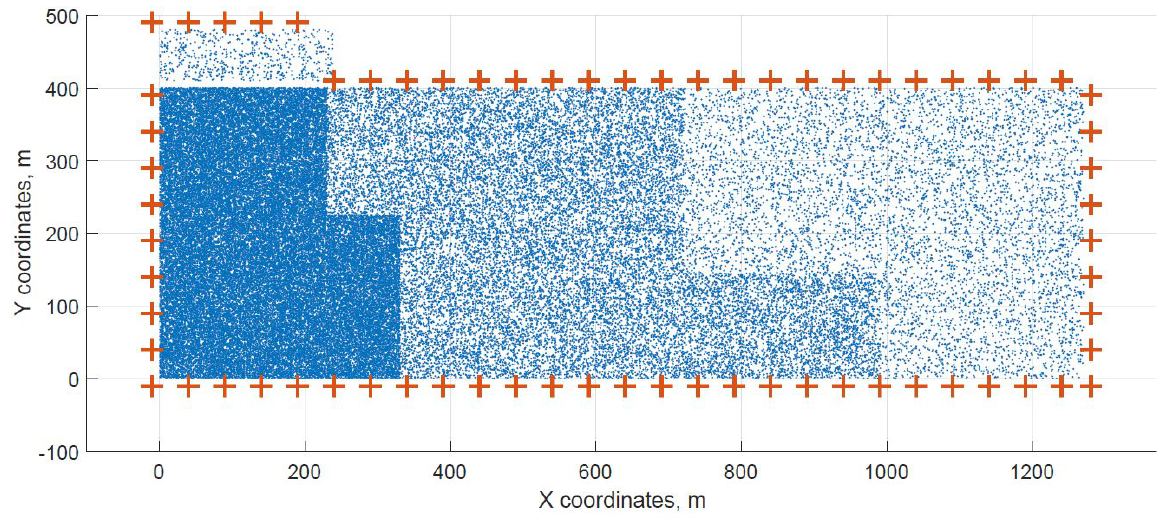
Figure 6. Original distribution with users outside of the area for dataset G. Table 7. Calculation results for CUCKS and DE algorithms using 10,000 iterations. Theor. No. of